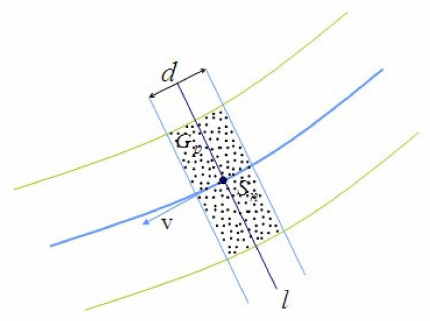
Figure 7. Generation of the tunnel cross-section.